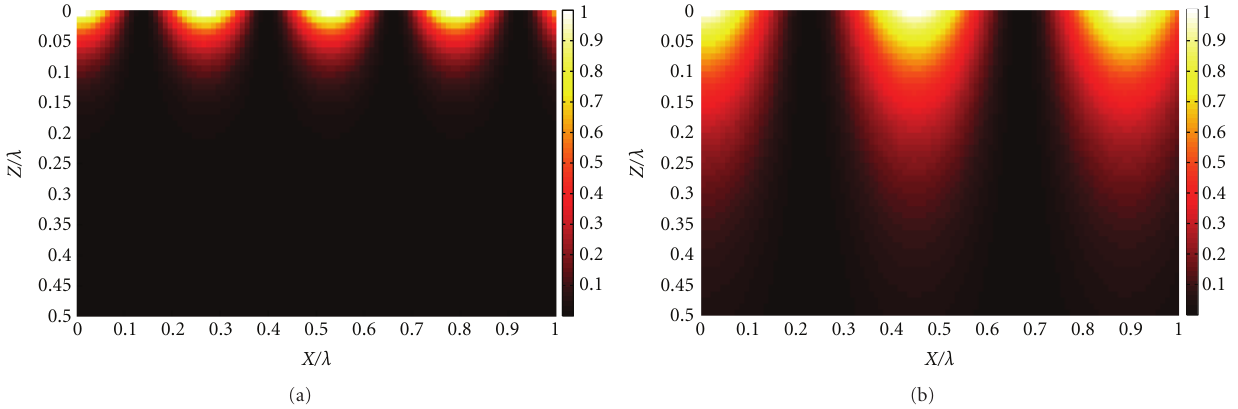
Figure 7: Electric field intensity profiles below 7 nm-34nm-7nm Al-Al 2 O 3 -Al stack (left) and 20 nm Al film (right) deposited on a sapphire